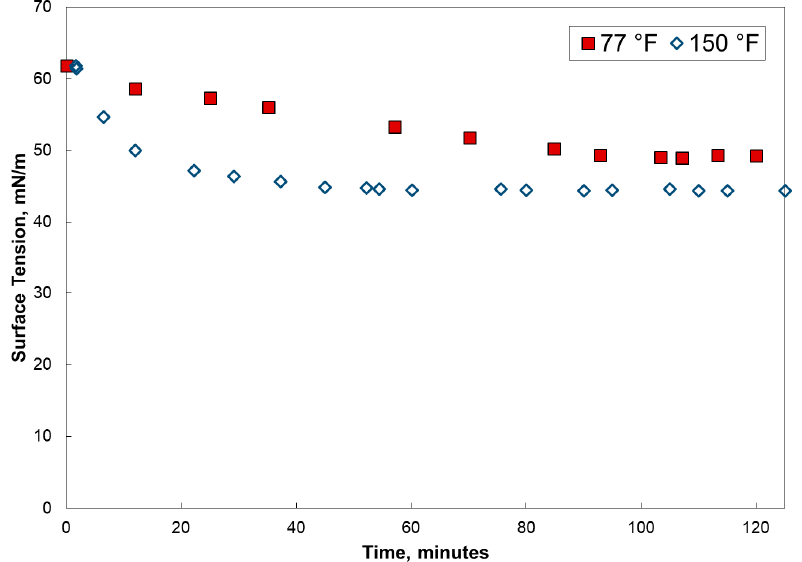
Figure 4. Time to reach equilibrium surface tension of surfactant-CO 2 system. The surfactant con- centration was 0.0005 wt%. The salinity and pH of the solution were 25 wt% NaCl and 6.5, respec-